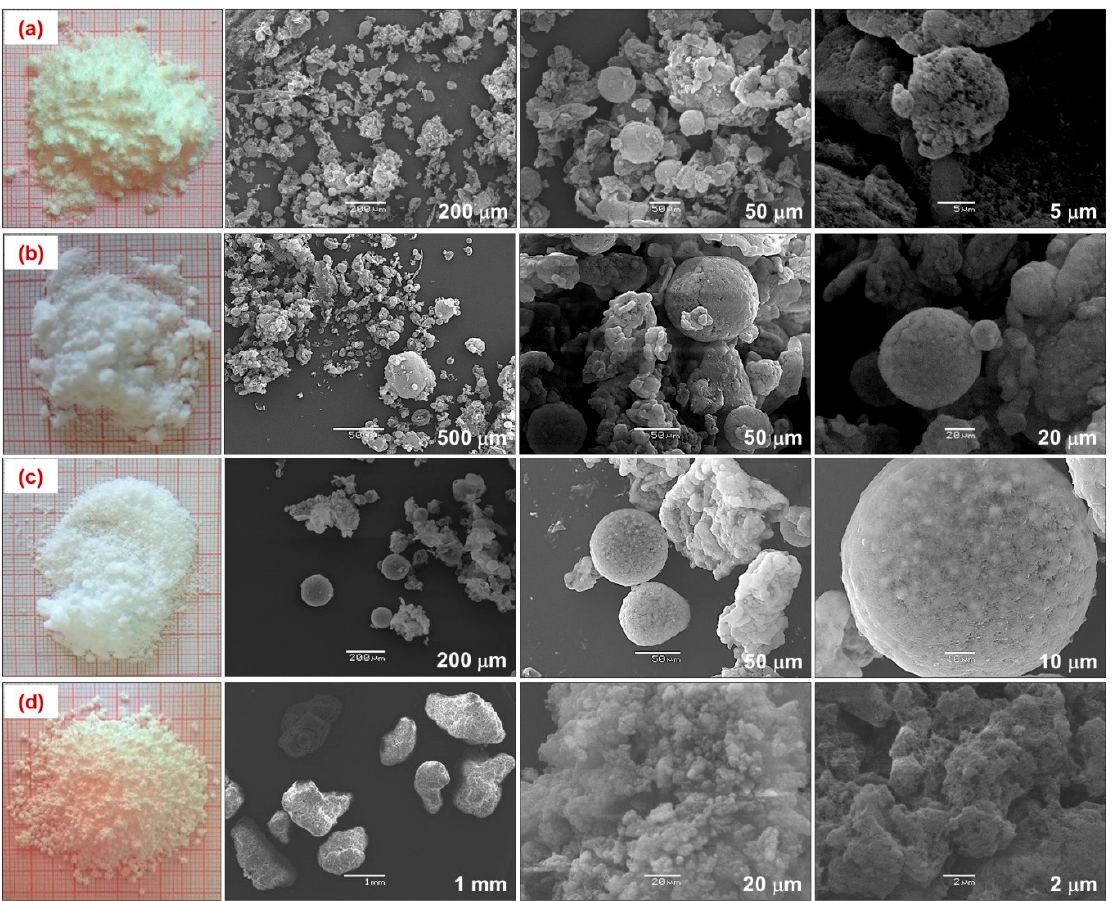
Figure 7. Photographs and SEM images at different magnifications of PUA powders prepared from Desmodur N3300 in propylene carbonate/hexane via emulsion polymerization. ( a ) CTAB 3.5% w/w; monomer concentration: 5.5% w/w. ( b ) CTAB 0.7% w/w; monomer concentration: 2.75% w/w. ( c ) CTAB 3.5% w/w; monomer concentration: 2.75% w/w. ( d ) NIKKOL BL-9EX 0.7% w/w; monomer concentration: 11% w/w. Scale lengths are indicated in the right-bottom corner of each frame.